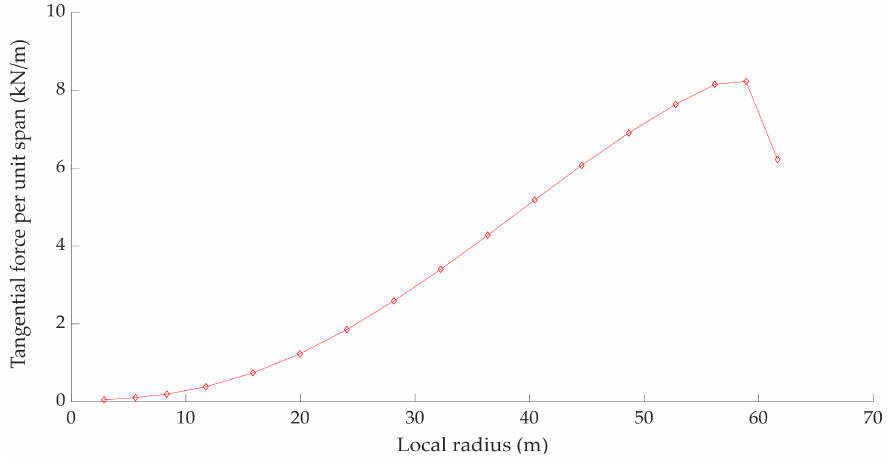
Figure 4. Tangential force per unit span as a function of the local